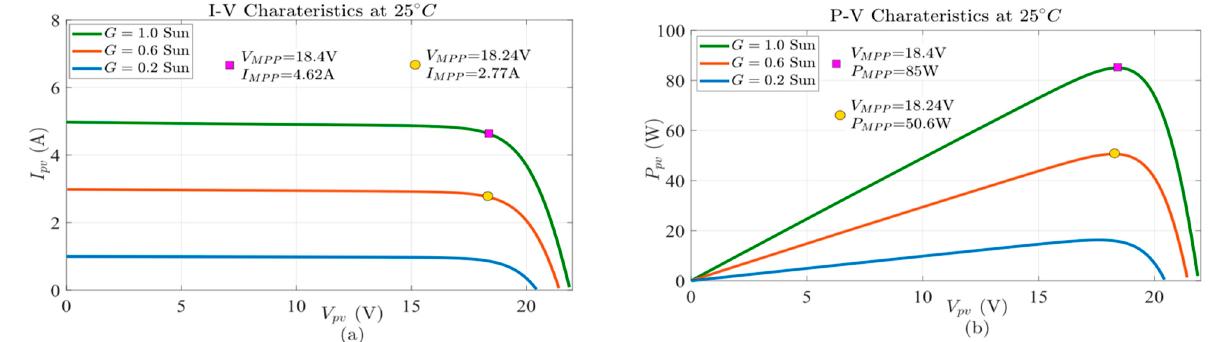
Figure 2. The effect of irradiance changes on the ( a ) I-V and ( b ) P-V characteristics.